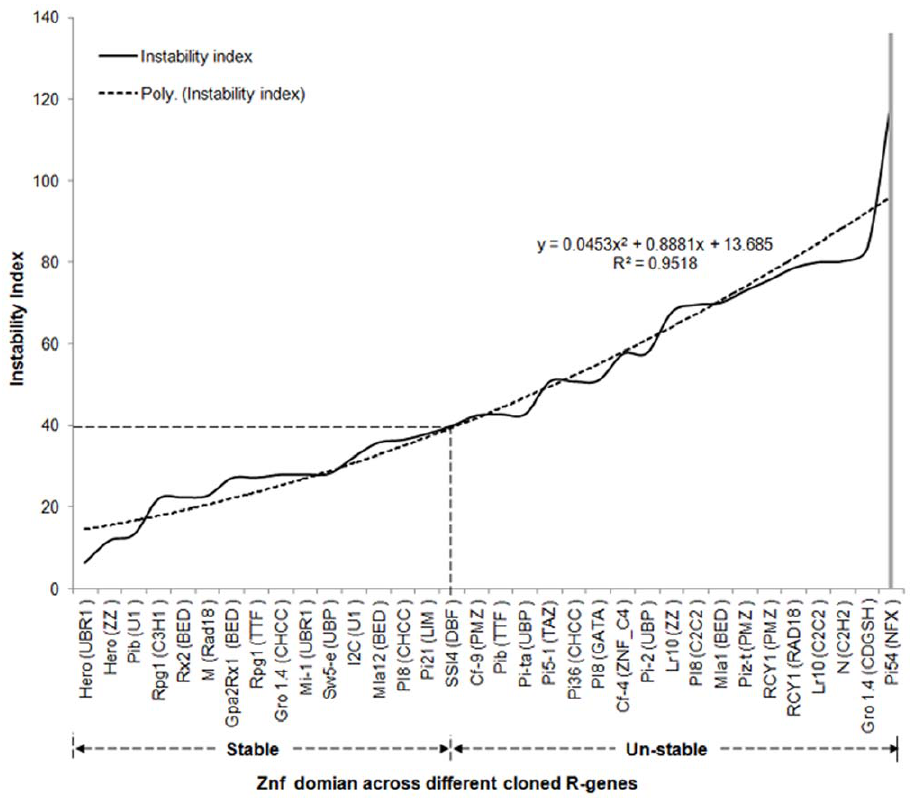
Figure 4. Instability index profile of identified zinc finger domain across cloned R gene. The data of 26 zinc finger R genes with their zinc finger types were included in this analysis.